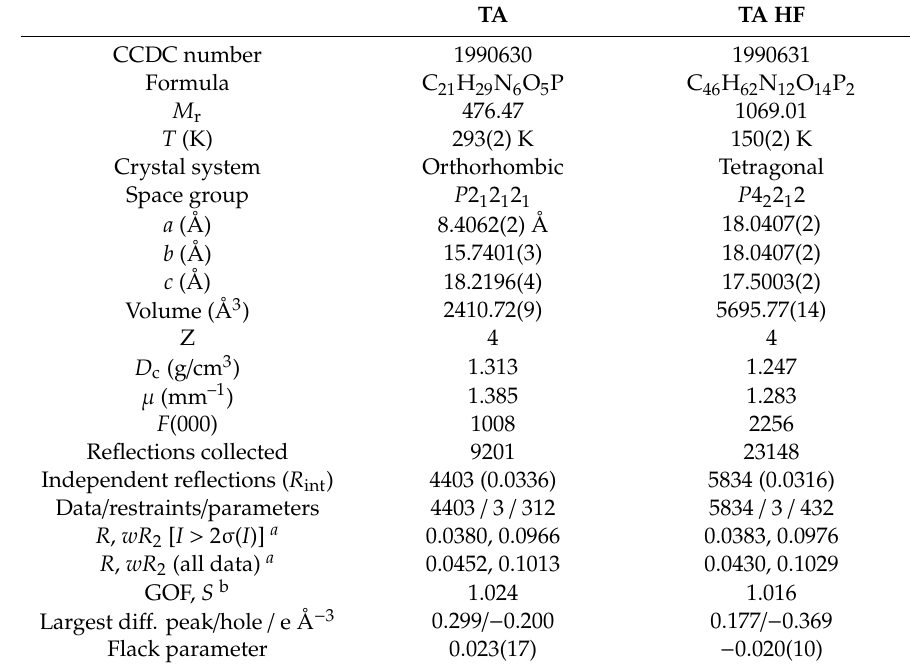
Table 1. Crystallographic data of tenofovir alafenamide (TA) and tenofovir alafenamide hemifumarate (TA